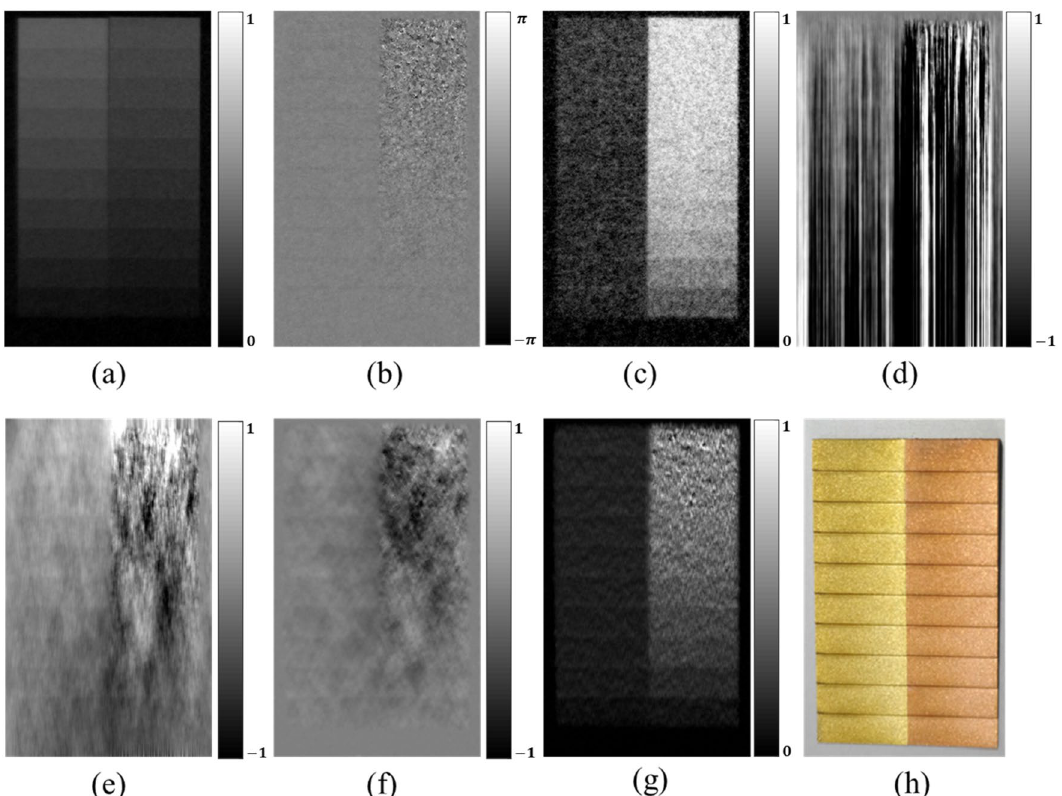
Figure 7. Comparison of PCI retrieval from neutron TLI images of brass and copper steps. ( a ) transmission, ( b ) DPCI, ( c ) dark-field, ( d ) direct integration, ( e ) WF filtering, ( f ) iterative method, ( g ) the proposed method, ( h ) visual image. The display window is [− 1, 1] for ( d ), ( e ), ( f ), and [0, 1] for ( g ). The total phase stepping number is eight.